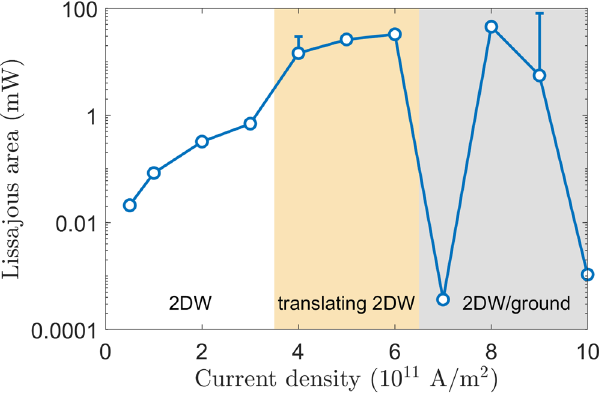
Fig. 8 Fragility of the 2 domain walls (2DW) state. We plot the area of the Lissajous curves as a function of the current density. As we can see, the area of the Lissajous curve depends strongly on the current density, and increases as a function of it. At low densities, the two domain walls are mostly static and the area is small, indicating a negligible memristive effect. At higher densities (yellow area), the domain-walls experience a noticeable distortion accompanied by a small yet fi nite periodic translation of the domain walls. At much higher current densities (gray area), translation dominates and phase slips can occur, leading to the destruction of the domain-wall pair such that the state of the system stabilizes into its ground state. These cases are evidenced by the low Lissajous areas. The stochastic nature of this regime is due to the cell's large aspect ratio. The error bars denote standard deviation of the area based on numerical fl uctuations and transient effects in the Lissajous' in Fig. 7a, b, respectively, along the path T ( θ ). The domain-wall with is estimated by the slope, m , of the pro fi le at its center, 2 R / m , where R is the mean radius of the ring. The microwave current is shown in both cases with a solid black curve. We note that the changes are small but the impact on the voltage is larger due to the details of the con fi guration in 3D.